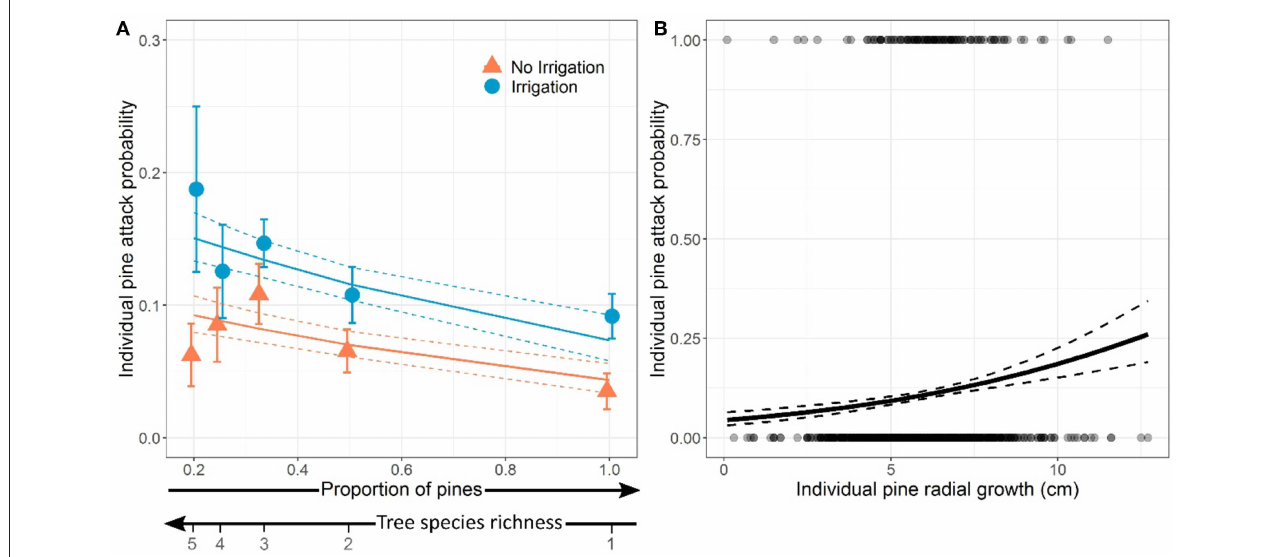
FIGURE 4 | Effects of proportion of pines (inversely proportional to tree species richness) and water treatment in the plot (A) and effect of individual pine vigor (radial growth) (B) on the probability of individual pine being attacked by Dioryctria sylvestrella . Dots and error bars in panel (A) represent the mean probabilities of pine being attacked ± standard-errors for each case of pine proportion. In (B) , dots at y = 0 and at y = 1 represent non-attacked and attacked trees, respectively. Model predictions and standard-errors are represented by solid and dashed lines,